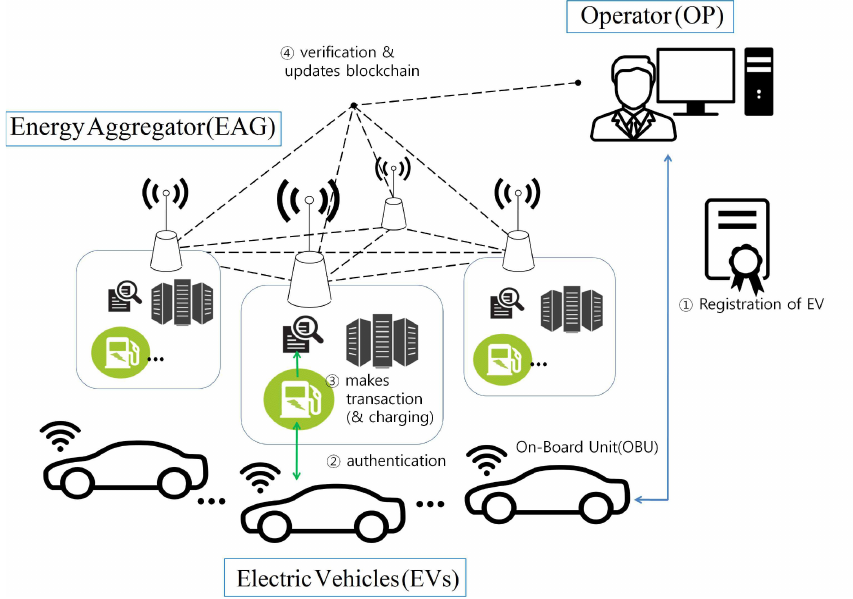
Figure 1. Proposed blockchain based charging system model for electric